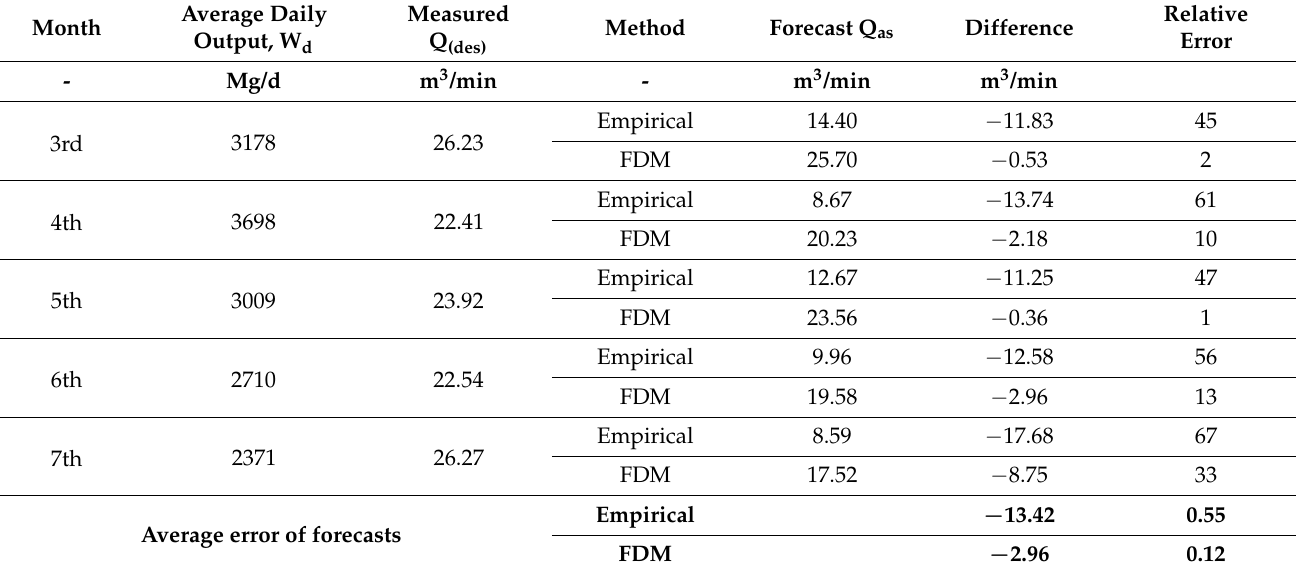
Table 5. Forecasting results for emitted methane volumes desorbed from adjacent strata to the longwall environment, obtained by means of the empirical method and FDM calculations, compared to the measured methane emission rates from adjacent